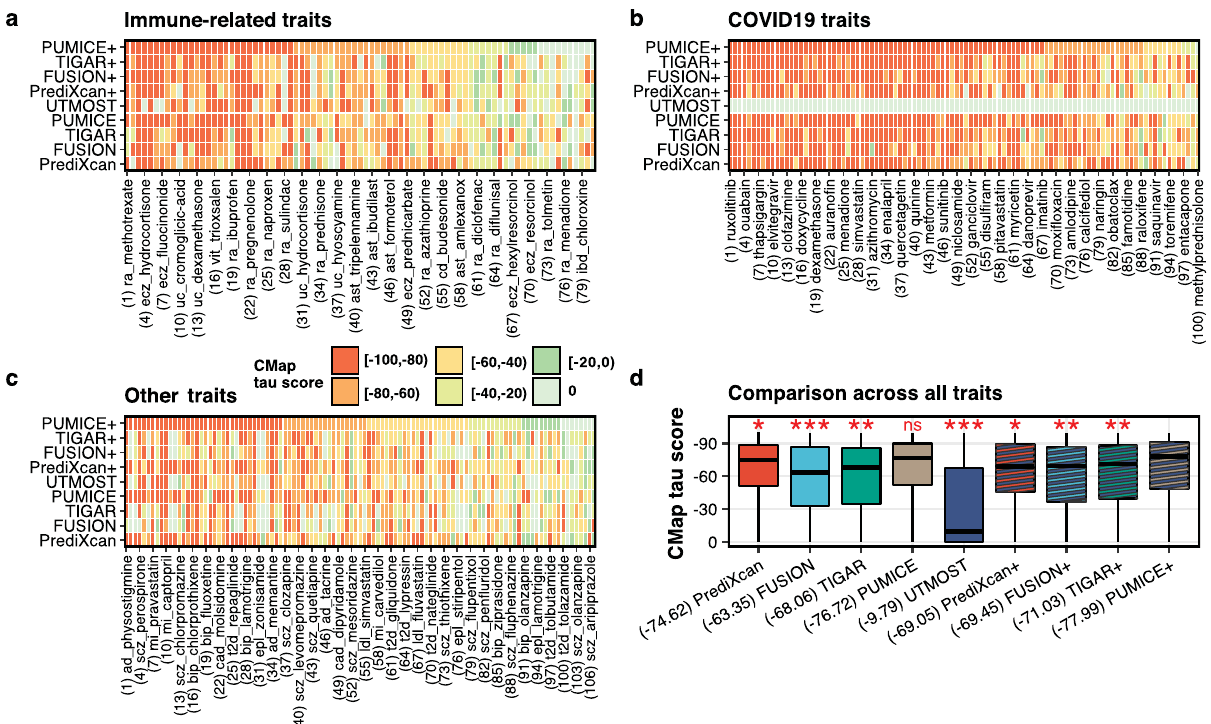
Fig. 6 Computational drug repurposing predictions for drugs with known indications in 23 traits. Panels ( a – c ) illustrates the heatmap of CMap scores derived from different TWAS methods for ( a ) immune-related traits, ( b ) COVID-19 traits, and ( c ) other traits. Due to the large number of trait-drug pairs, we only display text description of one for every three trait-drug pairs in the plot. Numbers in the parentheses are the indices of the displayed trait-drug pairs in the full list (Supplementary Data 16). Panel ( d ) displays the distribution of CMap scores across 23 traits. Median value is denoted in the parentheses. PUMICE + achieves the most negative median value of CMap score ( − 77.99), which shows that it identi fi es putative target genes that are most consistent with target genes of approved drugs. P- values are based on the comparison between PUMICE + and other methods using one-sided median test. The label “ ns ” denotes not signi fi cant; * denotes signi fi cance at p < 0.05; ** denotes signi fi cance at p < 0.01; *** denotes signi fi cance at p < 0.001. One-sided P- values are provided in the source data fi le. Minima and maxima values (excluding outliers) are represented by the lower- and upper- bound of the whiskers. Median value is represented by the bold line in the middle. First and third quartiles are represented by the lower- and upper-bound of the box. Trait abbreviations: ad = Alzheimer ’ s disease; ast = asthma; bip = bipolar disorder; cad = coronary artery disease; cd = Crohn ’ s disease; ecz = atopic dermatitis; epl = epilepsy; ibd = in fl ammatory bowel disease; ldl = low-density lipoprotein level; mi = myocardial infarction; ra = rheumatoid arthritis; scz = schizophrenia; t2d = type 2 diabetes; uc = ulcerative colitis; vit =